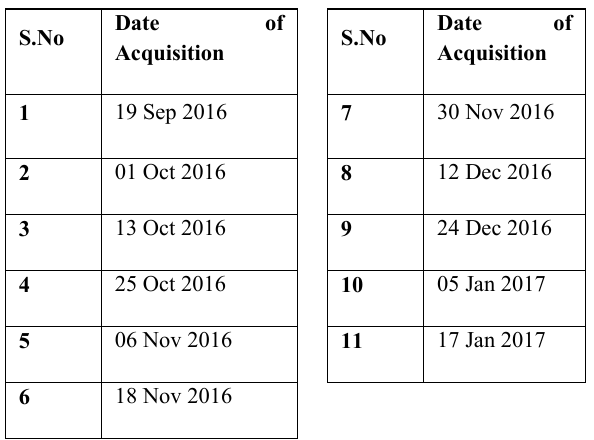
Table.4. Classification parameters used for rice pixel